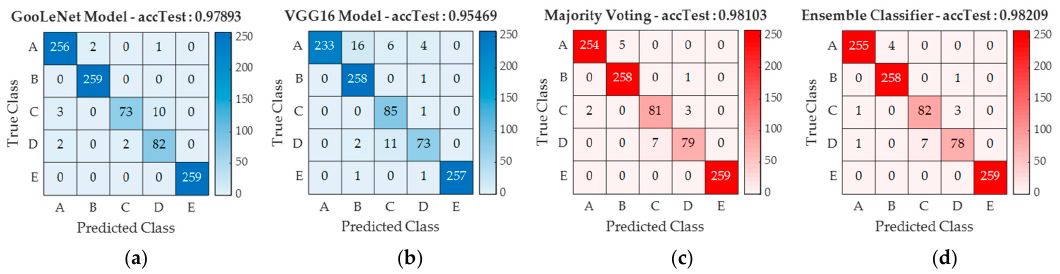
Figure 10. Confusion matrix: ( a ) best, ( b ) weakest, ( c ) voting, and ( d ) ensemble, of CLAHE dataset.